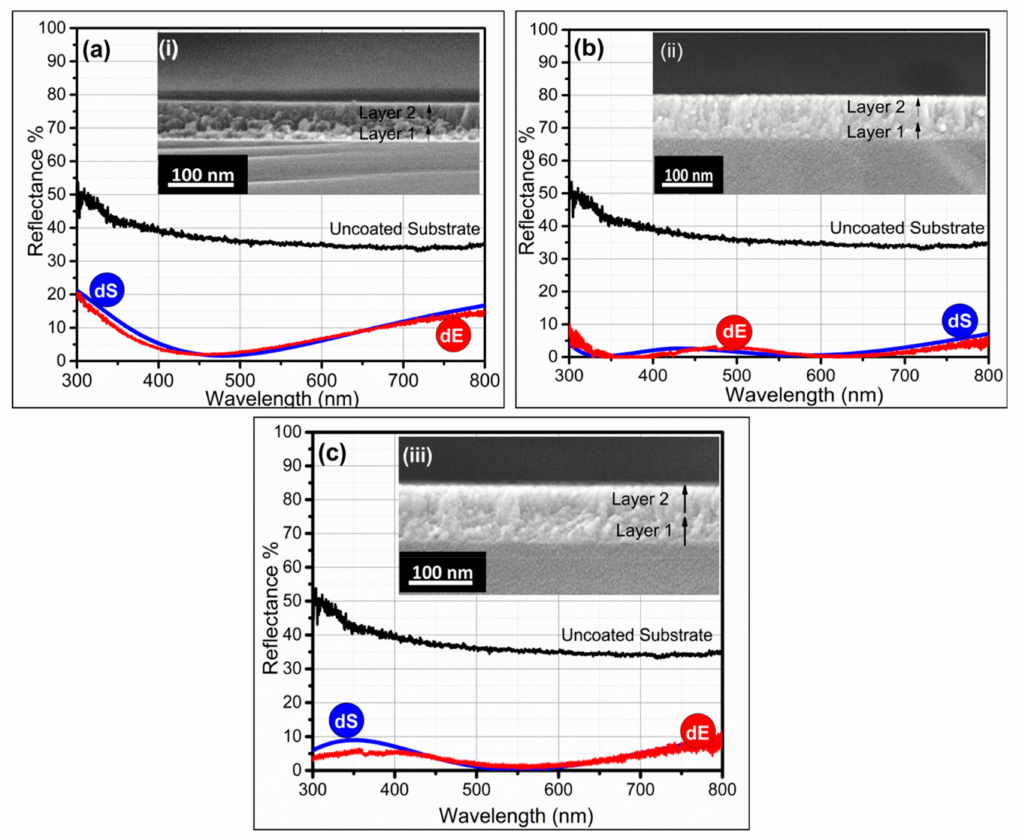
Figure 4. AR e ffi ciency of bilayer composite AR coatings on silicon ( a ) TiO 2 -HfO 2 , ( b ) TiO 2 -SiO 2 , And ( c ) HfO 2 -SiO